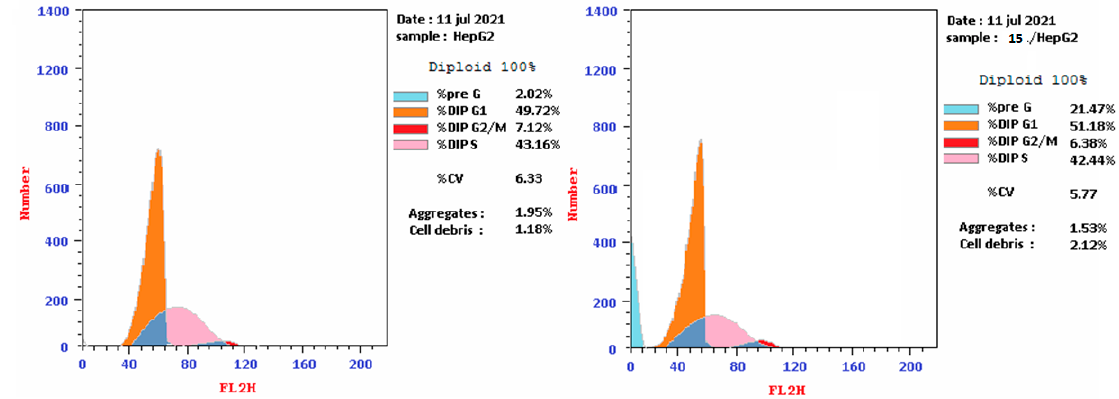
Figure 6. Flow cytometric analysis of cell cycle phases following treatment with compound 15.